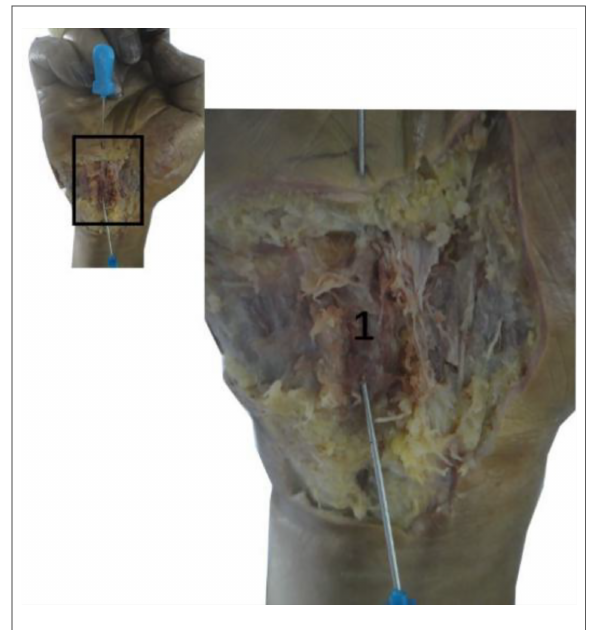
FIGURE 14 The needle knife penetrated the ulnar artery in the non-ultrasound guided group. 1, Ulnar artery.